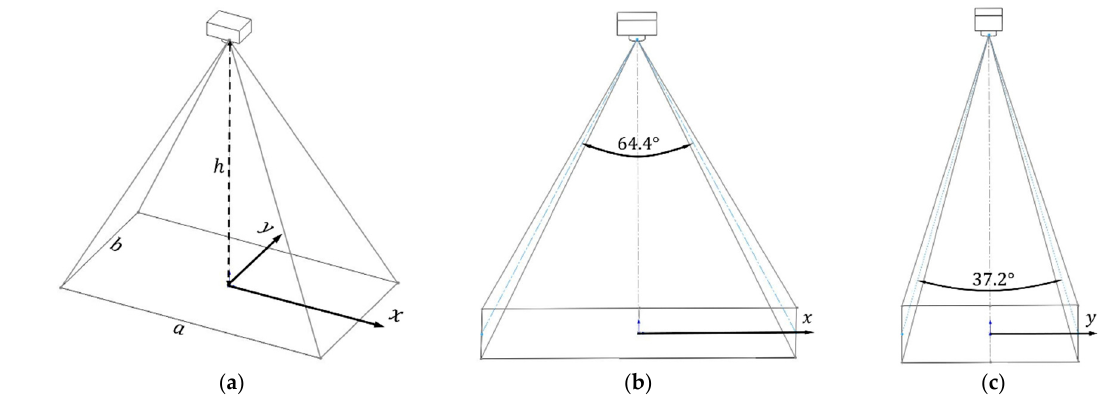
Figure 15. Camera and world coordinates.